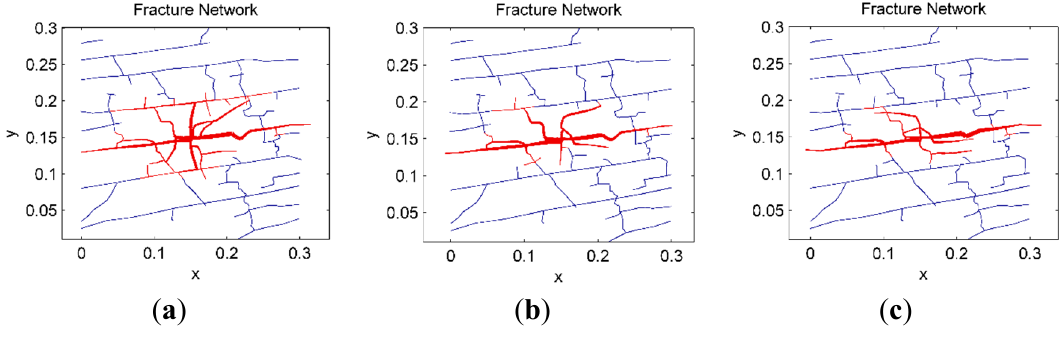
⁄ (cid:3404) 0.8 . The fractures affected by the fluid σ (cid:3051) (cid:3052)